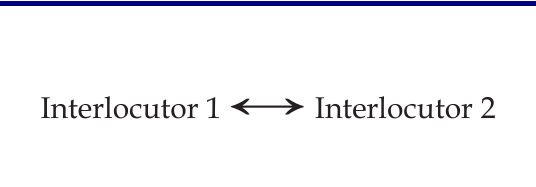
Figure 1: Dyadic Interaction